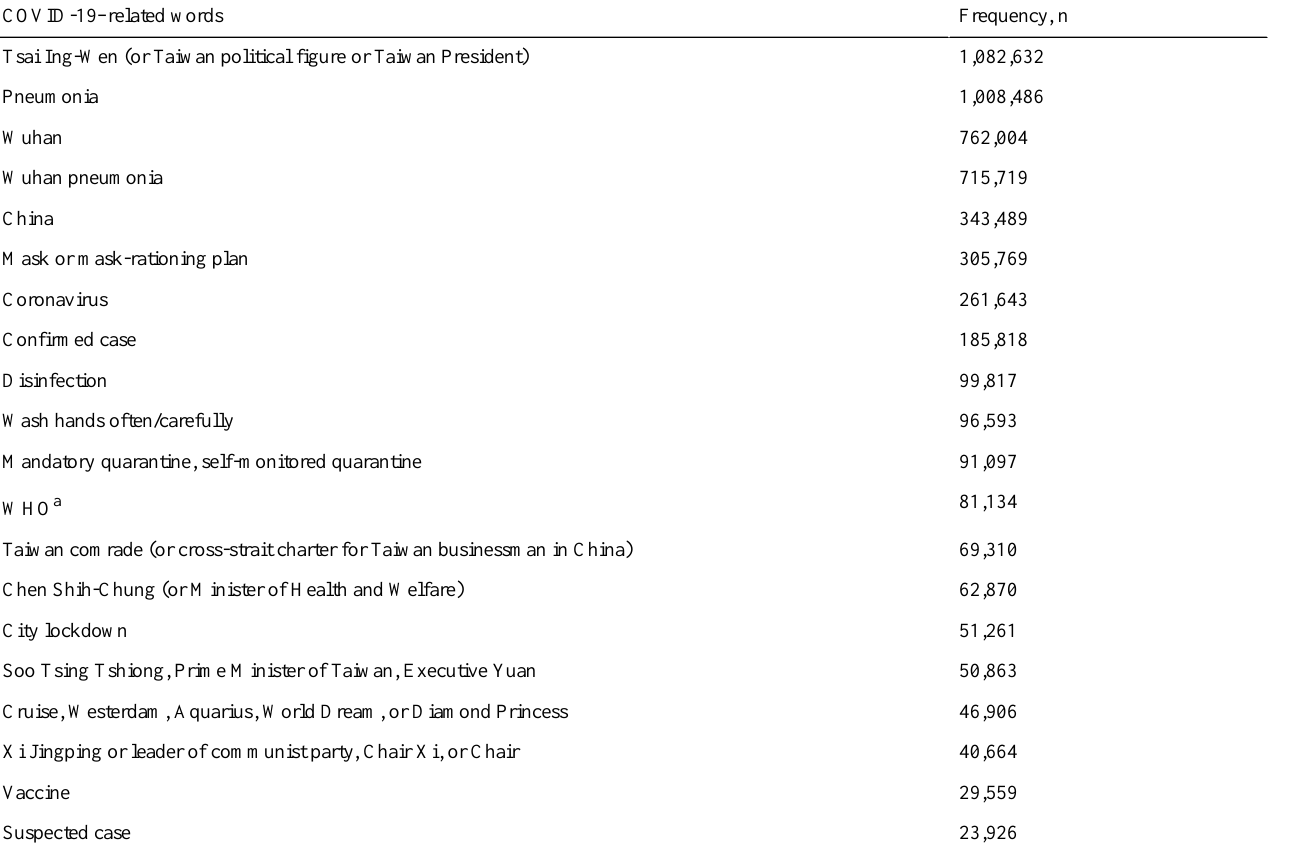
Table 1. High-frequency words related to COVID-19 in Taiwan’s online communication.